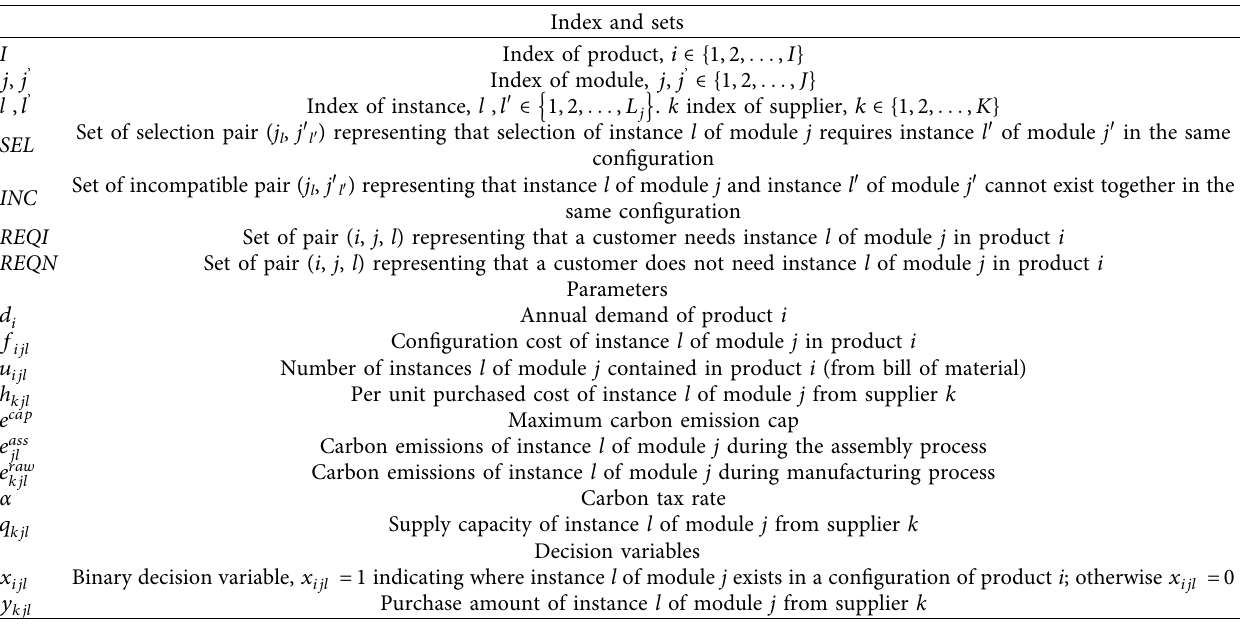
Figure 1: A general configurable product structure. Table 1: